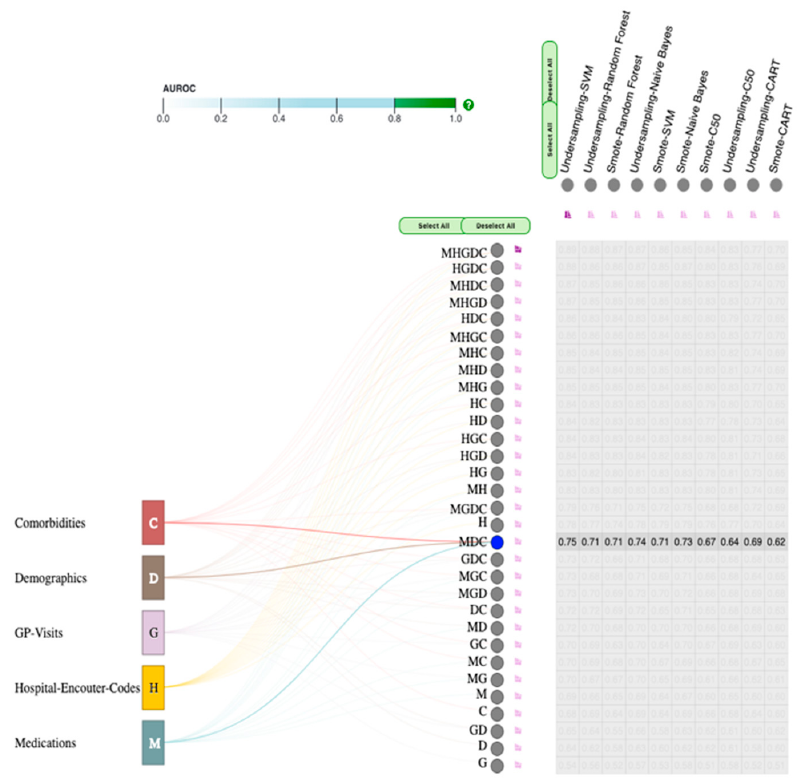
Figure 4. How the system gets updated when users hover over ( A ) or select ( B ) a rectangle representing groups. This interaction highlights all the cells corresponding to the selected subsets, group nodes that contain the selected subset, and links connecting the selected subset node and highlighted group nodes (Figure 5).